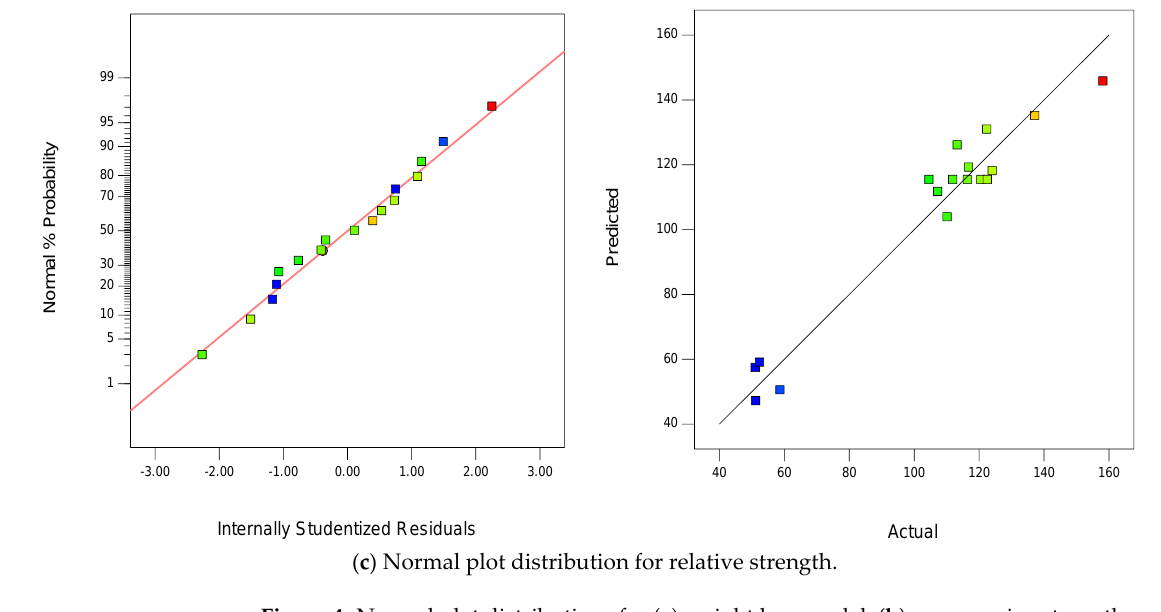
( c ) Normal plot distribution for relative strength. Figure 4. Normal plot distributions for ( a ) weight loss model, ( b ) compressive strength model, and ( c ) relative strength model.